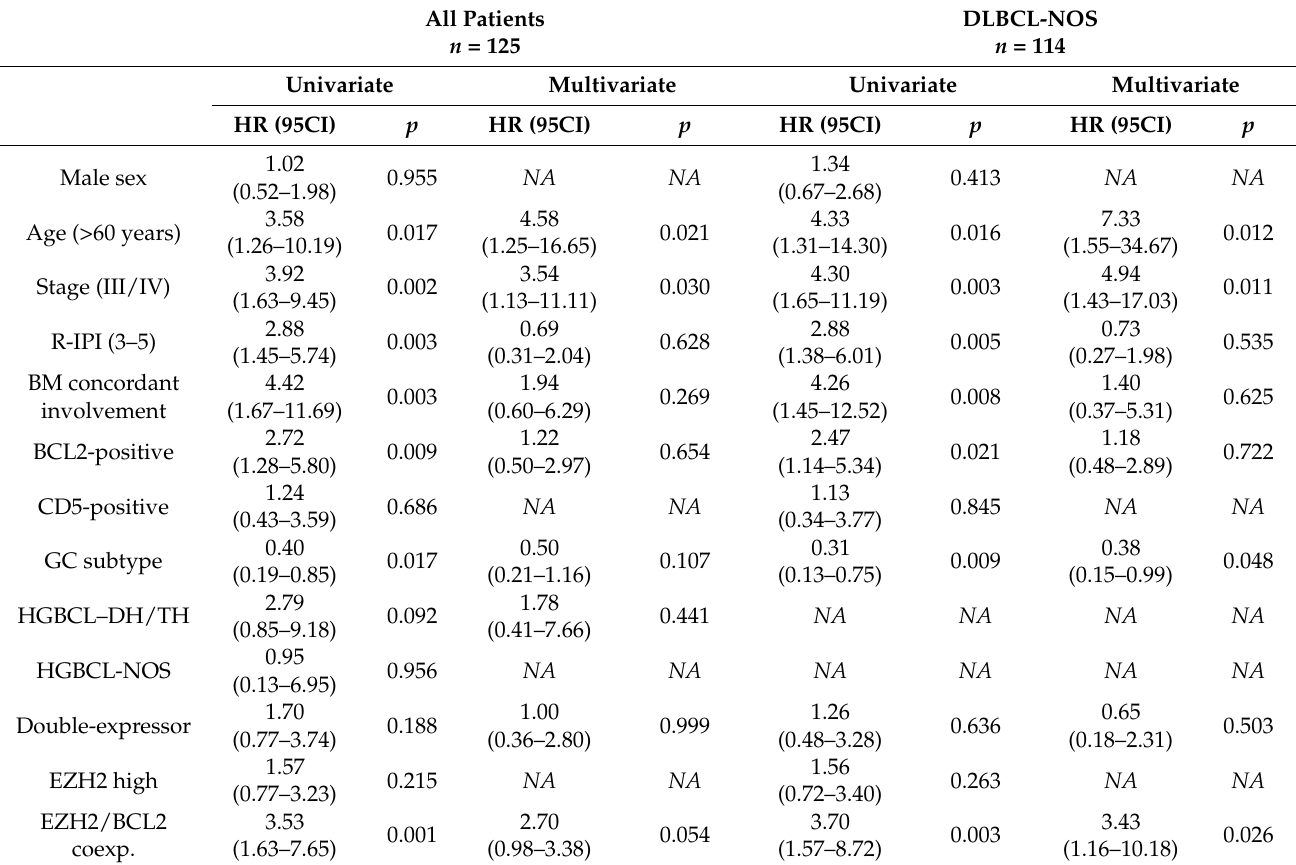
Table 3. Univariate and multivariate * analysis of secondary endpoint (overall